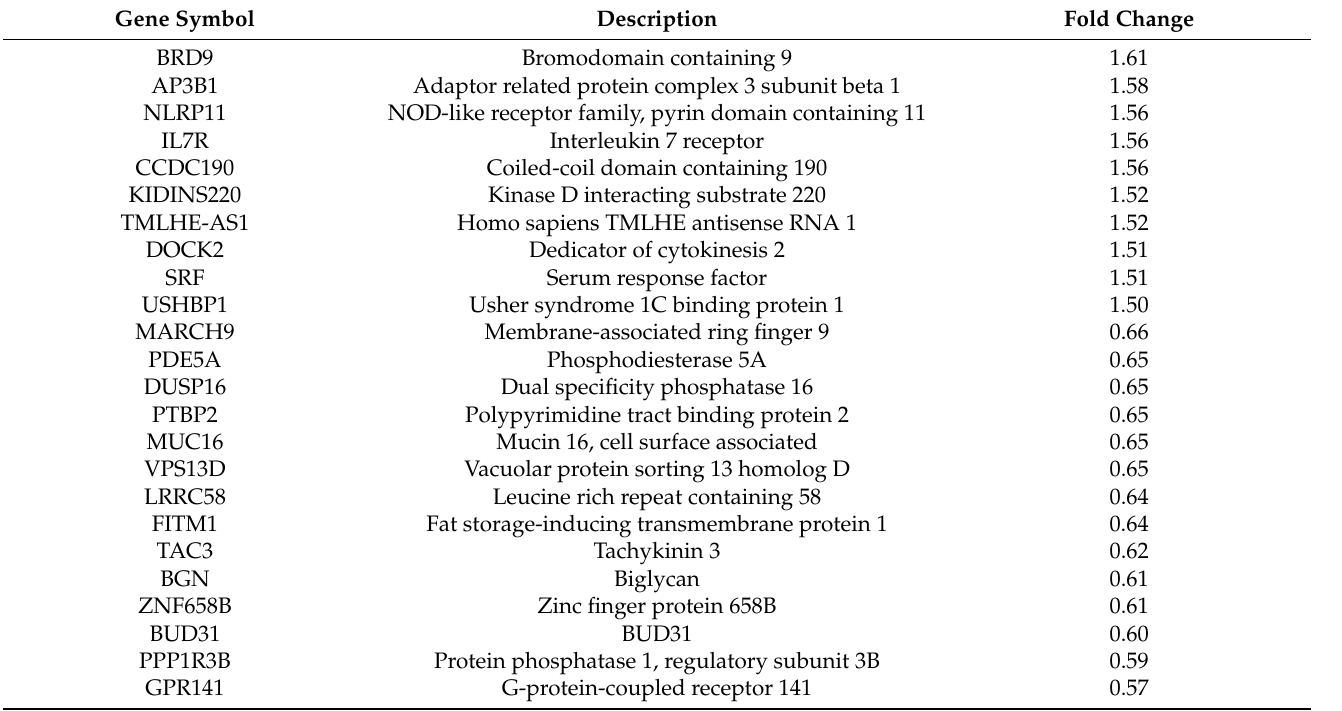
Table 1. Significantly altered transcripts ( p -values < 0.05) in HeLa cells treated with RhNPs and NIR irradiation. Gene